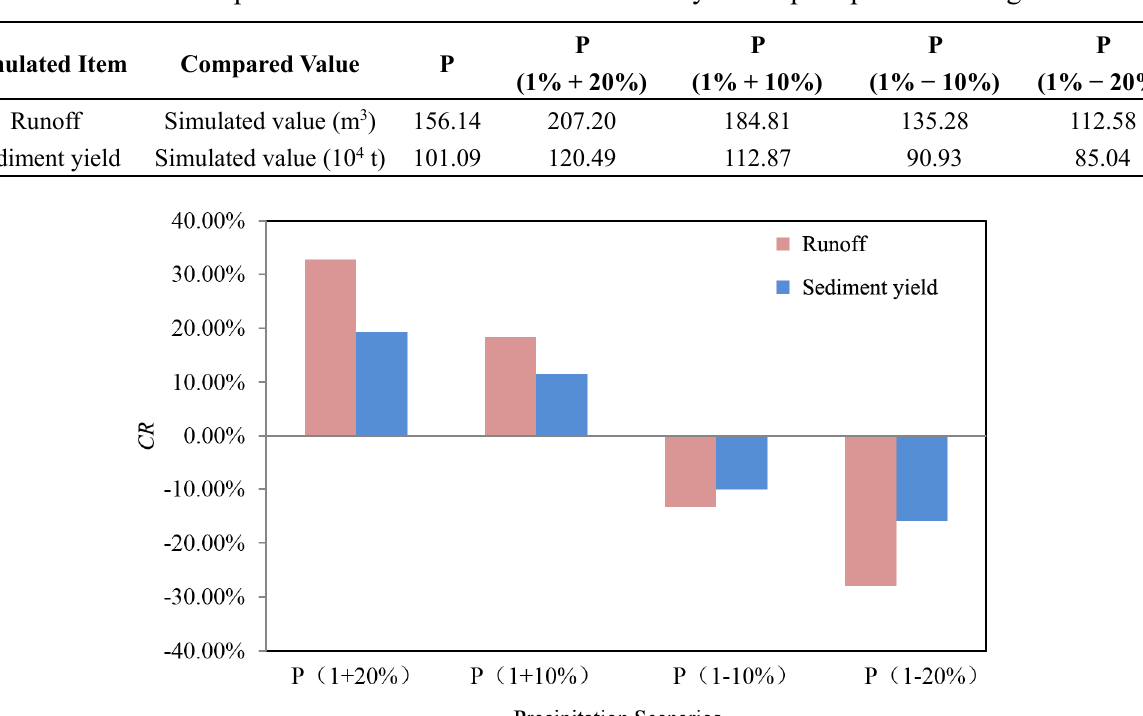
Table 4. Responses of annual runoff and sediment yield to precipitation changes.